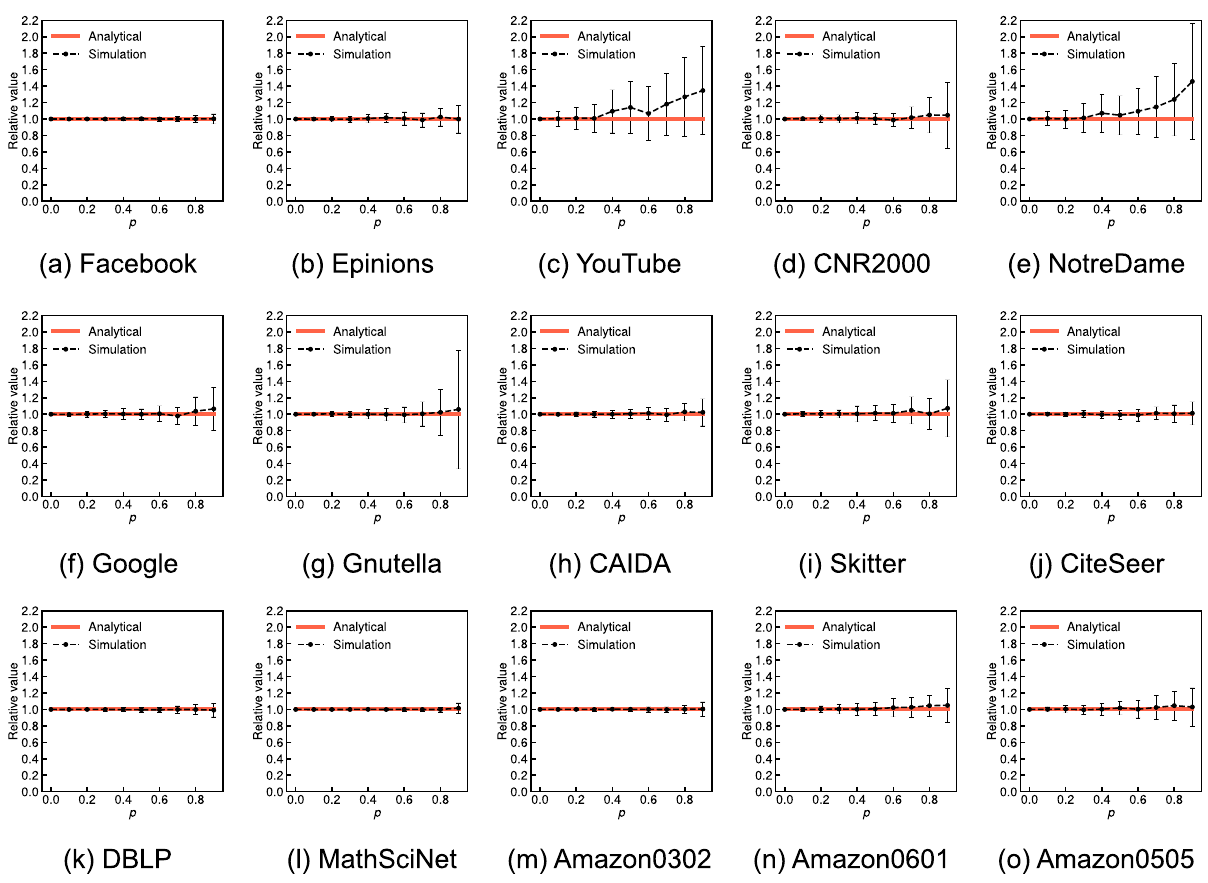
Figure 4. Comparison of the analytical and simulation results for the relative global clustering coefficient when each node is independently missing with probability p on 15 real-world network datasets. The error bar indicates the standard deviation across 100 independent sets of randomly missing